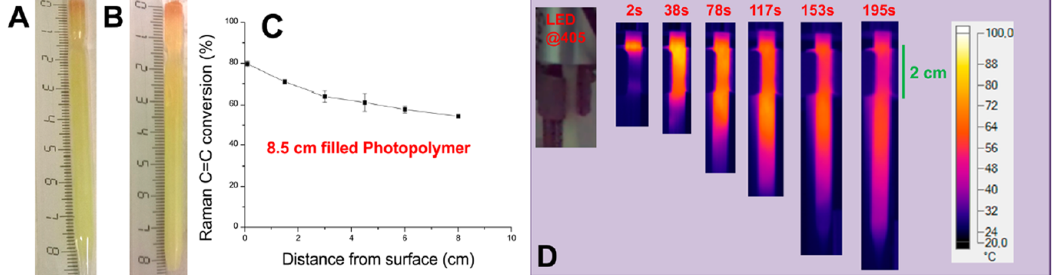
Figure 18. Pasteur pipette containing the resin before ( A ) and after ( B ) breaking the pipette; ( C ) monomer conversion as a function of the distance; ( D ) evolution of the temperature as a function of the reaction time followed by infrared thermal imaging camera. Reproduced with permission from the authors of [28]. Copyright 2017 American Chemical Society.